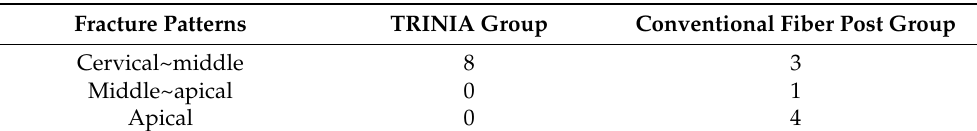
Table 2. Fracture Loads and Patterns of Bovine Roots Restored with Fiber-Reinforced Post-Cores and Zirconia Crowns.